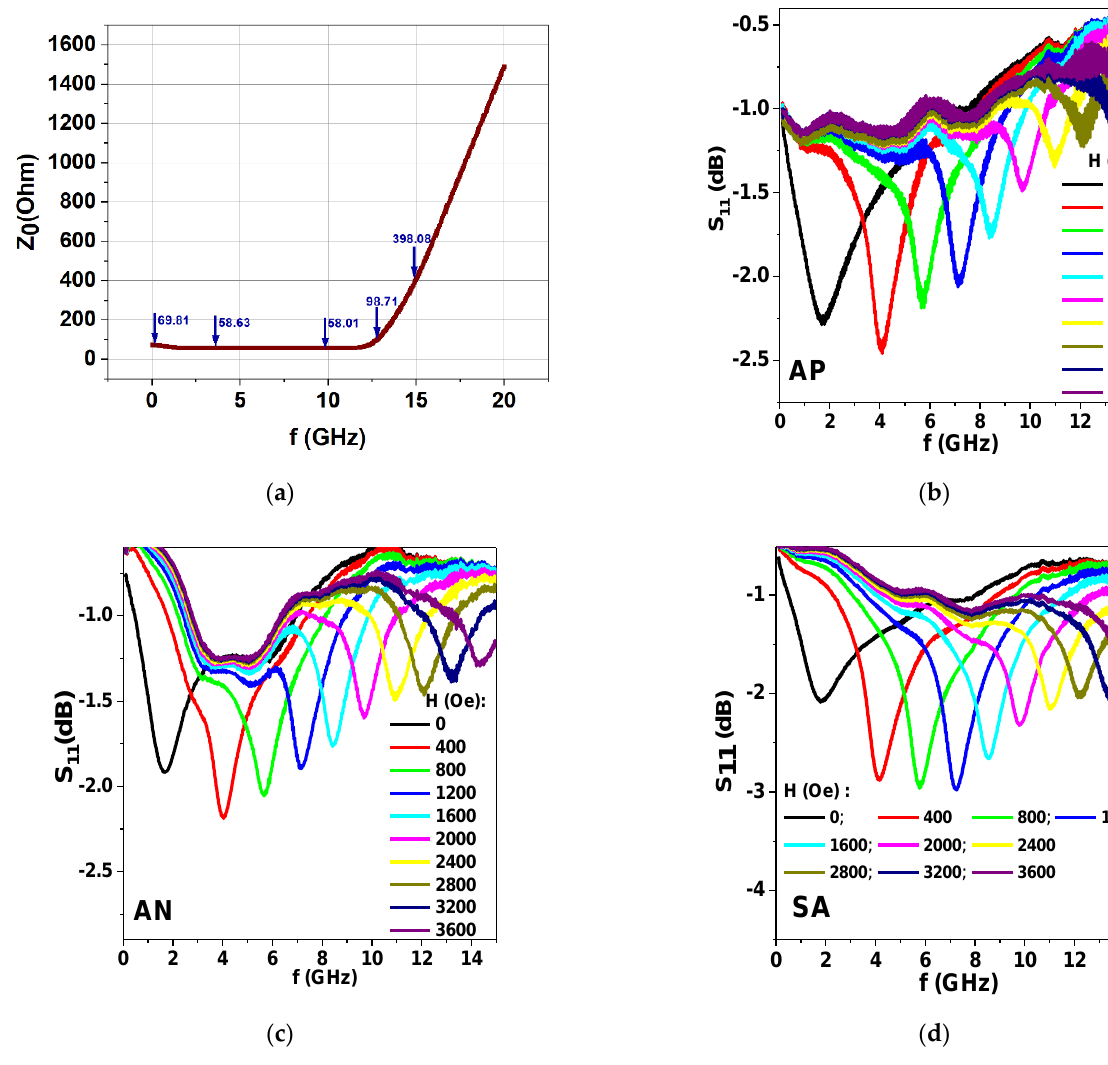
Figure 8. ( a ) Calculation of characteristic impedance Z 0 (values indicated by blue arrows) of a waveguide consisting of a coaxial line and a thick planar sample. Blue arrows show the simulation results for the approximation to the 50 Ohm matching waveguide characteristic impedance (in the frequency range of 0.5 to 12.5 GHz). ( b – d ) S 11 parameters measured in the broadband regime for Fe 3 Co 67 Cr 3 Si 15 B 12 amorphous ribbons in different states AP, AN and SA for the external magnetic field applied in the plane of the ribbons. The measurements were made for different values of the external magnetic field.